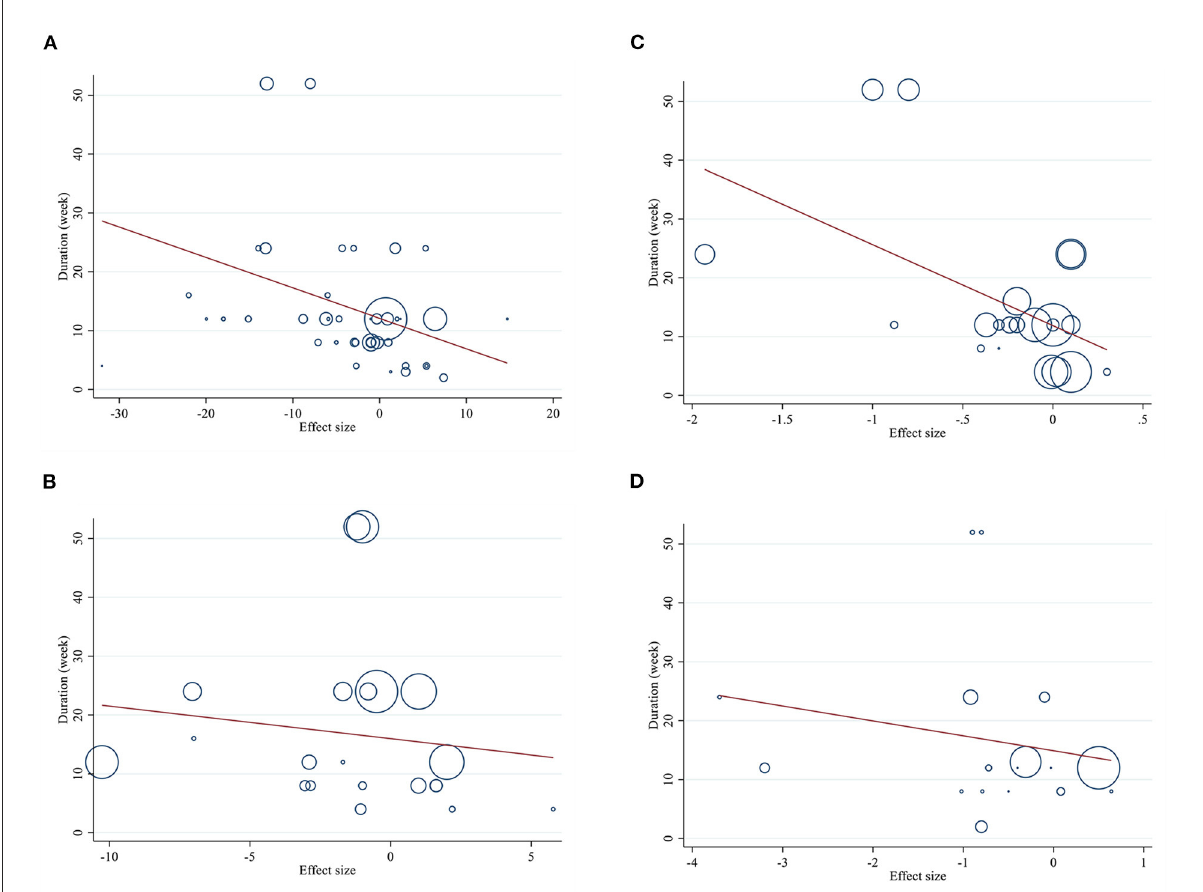
FIGURE7 Linear relations between L-carnitine consumption and absolute mean differences. Dose-response relations between duration of intervention (week) and absolute mean differences in (A) FBG (mg/dl); (B) Insulin (pmol/l); (C) HbA1c (%); (D) HOMA-IR. FBG, fasting blood glucose; HOMA-IR, homeostasis model assessment for insulin resistance; HbA1C, hemoglobin